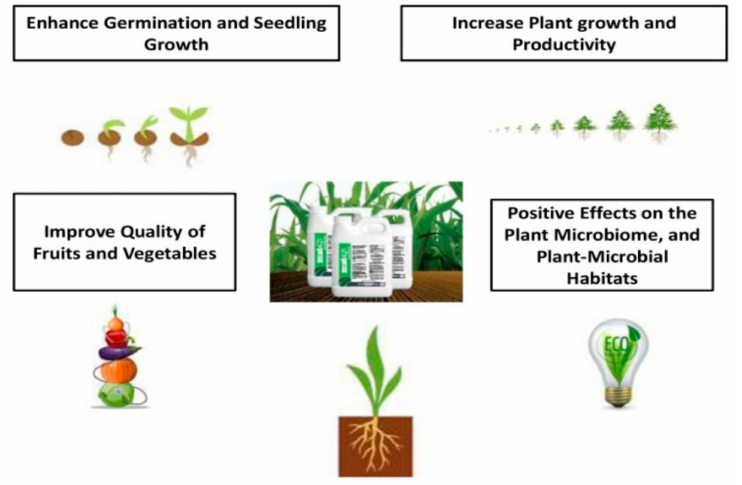
Figure 2. Protein hydrolysates biostimulatory